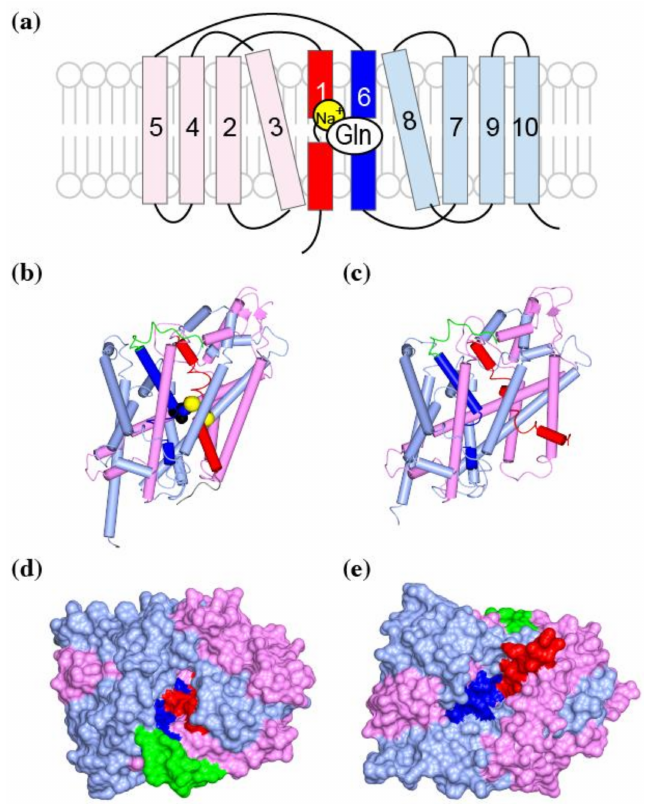
Figure 6. Structure of LeuT, a bacterial homolog of the glutamine transporter SNATs: ( a ) Topology diagram of APC family transporter domain. TM1 is in red, TM2–5 are in pink, TM6 is in blue, and TM7–10 are in light blue; ( b ) A worm and tube diagram of LeuT colored as in ( a ), in a substrate leucine (spheres) bound, outward-occluded conformation. The fourth extracellular loop is in green, and the sodium ions are yellow spheres. PDBID:2A65; ( c ) A surface representation of ( b ) from the extracellular side. The pocket for substrate binding is occluded by TM1 (red) and TM6 (blue); ( c ) LeuT in an inward-open conformation, colored as in ( a ). PDBID:3TT3; ( d , e ) Surface representations of ( b , c ) from the extracellular or intracellular side of the molecule,